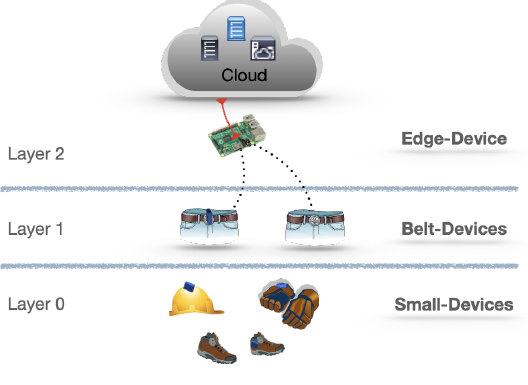
Figure 5. The Fog-Computing